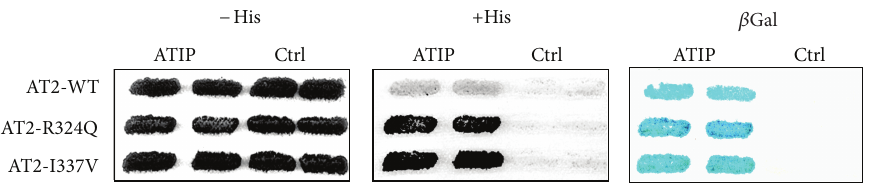
F 2: Interaction between ATIP1 and wild-type or mutated AT2 receptors. e C-terminus domain of ATIP1 (ATIP) interacts with the C-terminal region of human AT2 receptor, either wild-type (WT) or mutated (R324Q, I337V). e yeast reporter strain HF7 expressing the pairsofindicatedhybridproteinswasanalyzedforhistidineauxotrophyand plated on medium with histidine (le�), without histidine (His, middle), or replica-plated on Whatman �lters and tested for activity ( Gal, right). Growth in the absence of histidine and blue color in the proteins (WT: wild-type sequence; Ctrl; empty 𝛽𝛽